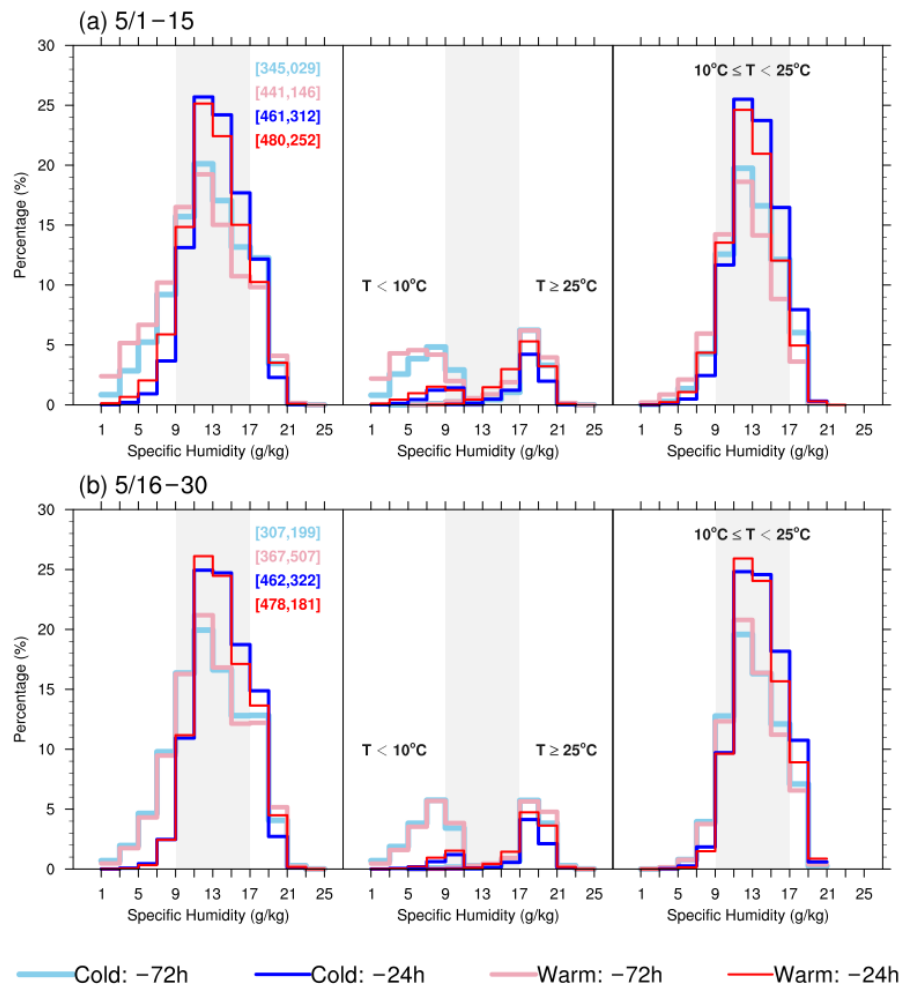
Figure 12. The probability distributions of the specific humidity carried by the backward trajectories at the backward times of 72 and 24 h are presented for the 15-day periods of ( a ) 1–15 May and ( b ) 16–30 May. The probability is computed as a relative frequency; that is, the counts in each humidity bin divided by the total counts of the trajectory remaining within a subdomain (5 ◦ –18 ◦ N, 80 ◦ –120 ◦ E) at the corresponding backward times. Similar patterns of distributions are obtained by using the calculation domain (10 ◦ S–25 ◦ N, 70 ◦ –130 ◦ E) for backward trajectory. The left panels are for the specific humidity from all trajectories; the central and right panels are the marginal probability of specific humidity with respect to the temperature values. The numbers in square brackets (left panels) are the total counts of the trajectory remaining in the subdomain at the corresponding backward